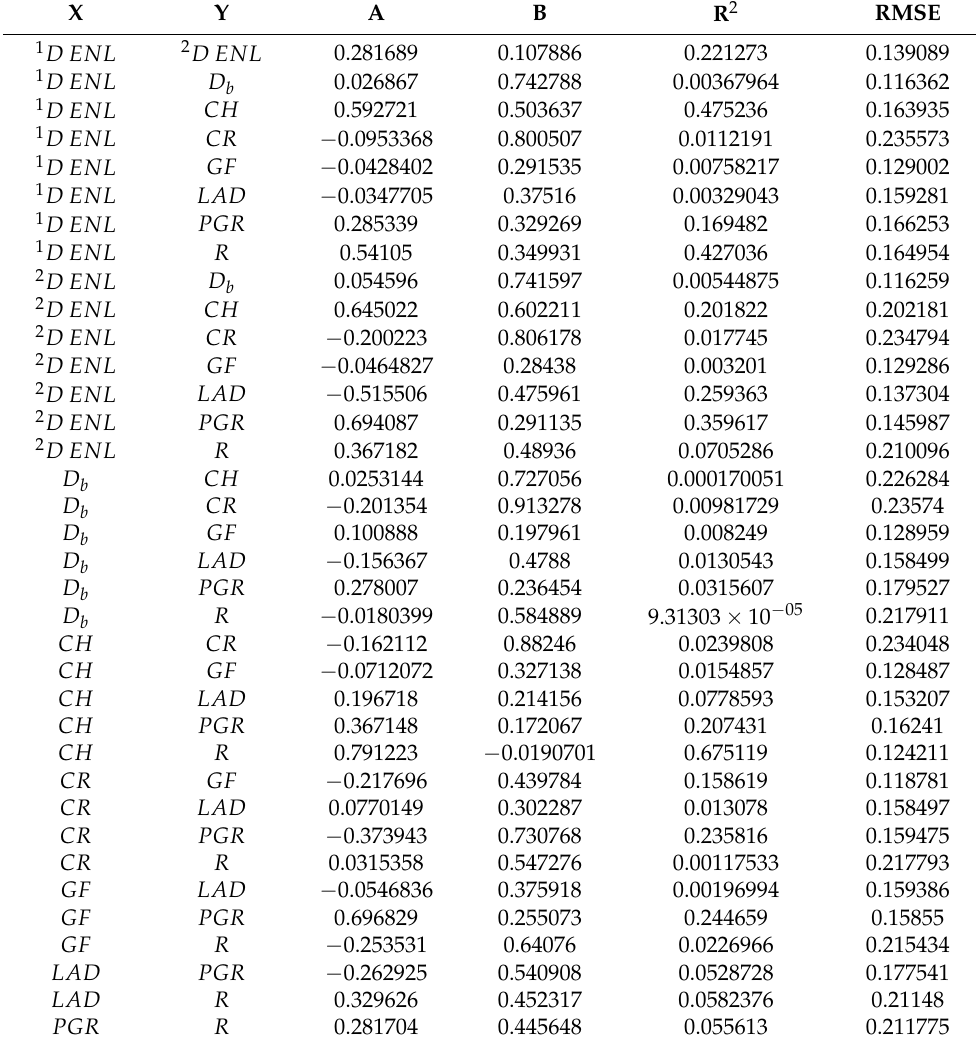
Table A11. Overview of TLS linear regression at 1m grid size.